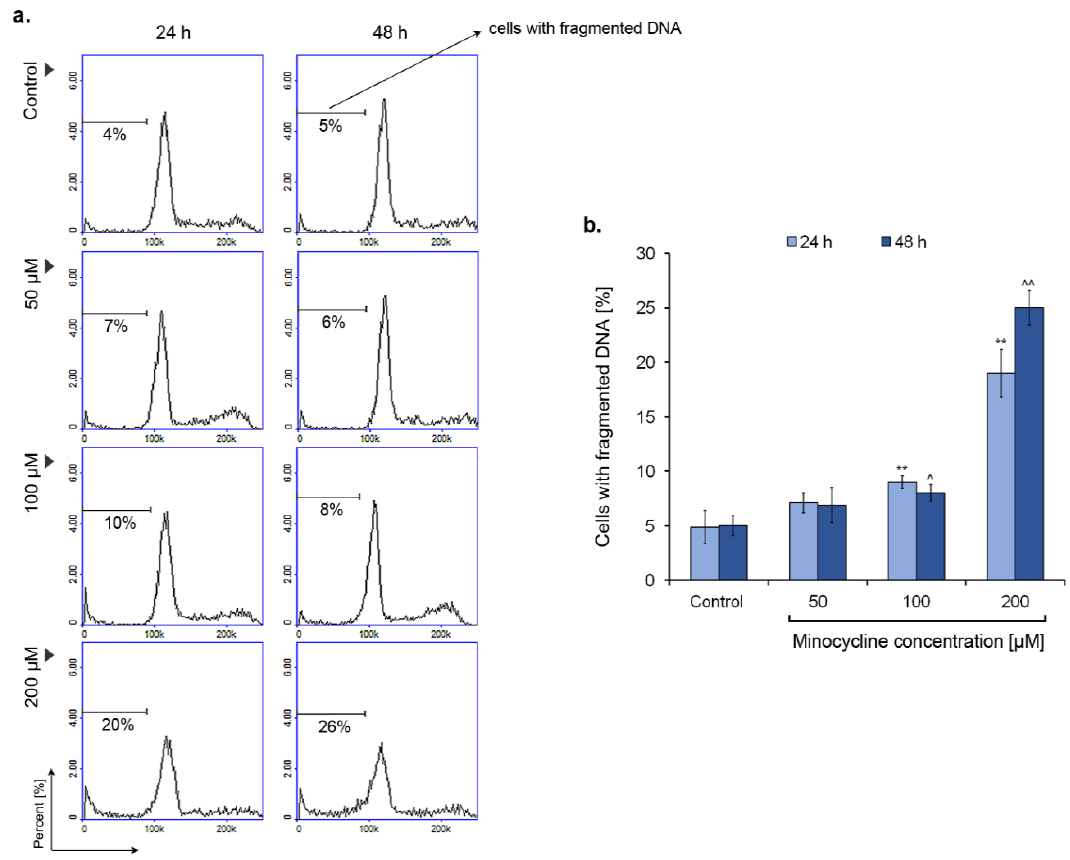
Figure 8. The influence of minocycline on DNA fragmentation in human melanoma cells after 24 h and 48 h treatment. The presented histograms respond to representative results of the experiments ( a ). Mean values of the percentage of cells with fragmented DNA are shown in the bar graph ( b ). ** p < 0.005 vs. control 24 h; ^ p < 0.05, ^^ p < 0.005 vs. control 48 h.